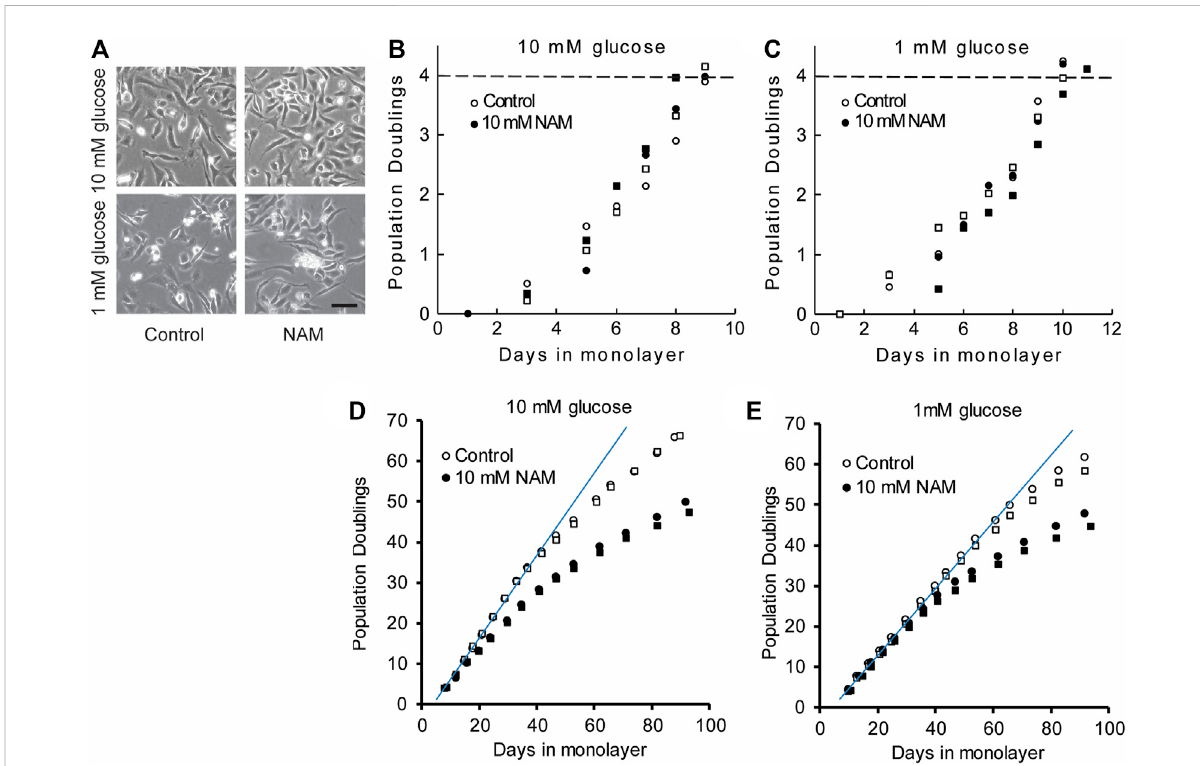
FIGURE 3 Chondrocytes have similar morphology and early proliferation kinetics in the presence or absence of the sirtuin inhibitor, NAM. (A) ChondrocytesexpandedinmonolayerexhibitedsimilarmorphologyregardlessofglucoseconcentrationorsirtuininhibitionwithNAM,illustratedby representative images at day 6. Scale bar 100 µm. (B,C) Proliferation kinetics data for chondrocytes expanded for 4PD in (B) 10 mM glucose and (C) 1 mM glucose with and without NAM. Data from two experiments indicated by circles and squares. The population doubling times calculated fromthelinear regionofthepopulationdoubling/days inmonolayerplots (B,C) were1.49±0.11and1.47±0.12 days (mean±s.e.m.)forcontrol and NAM treated cells respectively. The fi nal population doubling number at which cells were harvested to prepare cell pellets, indicated by the dashed line in (B) and (C) was 4.06 ± 0.08 and 4.05 ± 0.06 (mean ± s.e.m.) for control and NAM treated cells respectively. (D,E) Long-term proliferation kinetics in which a linear fi t indicates the trajectory of the initial linear growth phase. During long-term culture, premature proliferative arrest was observed in the presence of NAM treatment for both 10 mM and 1 mM glucose media (D,E) , illustrated by earlier deviation from linear growth compared to cells without